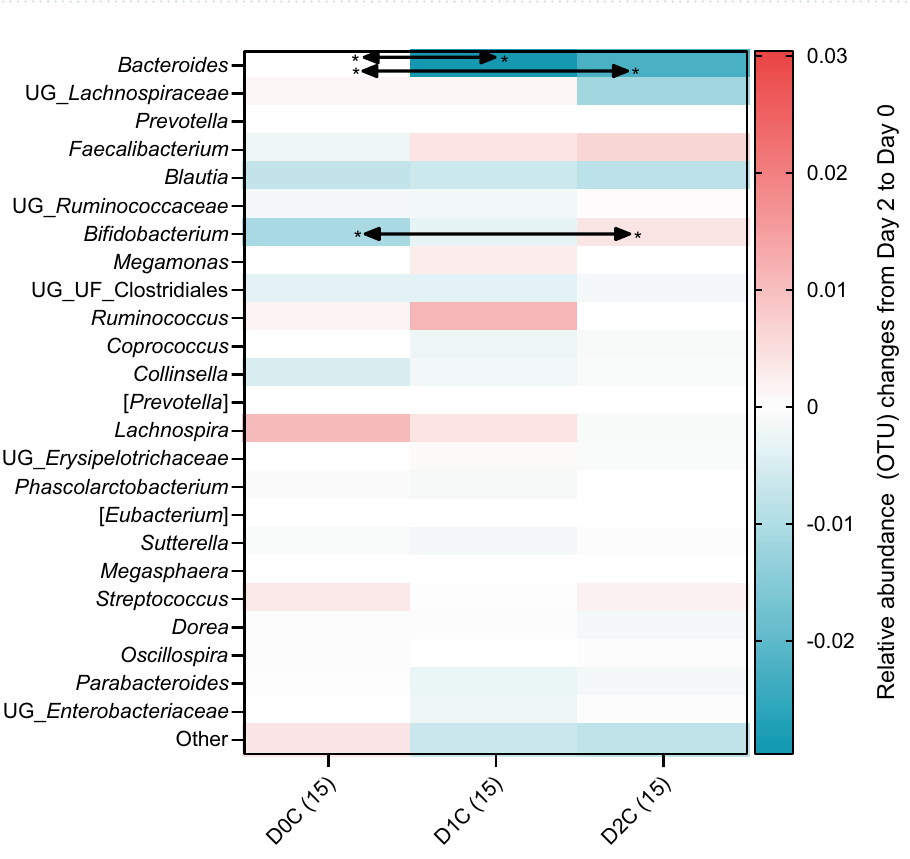
Figure 2. Alpha diversity of the three different doses of spices intervention ( a ) Chao 1’s and ( b ) Shannon’s indexes were measured and described at Y axis. No significant difference between spices intervention were found by Friedman’s test with Dunn’s multiple comparison within Day 0 or Day 2. The types and days of intervention were drawn as different symbols and colours. + shows mean. D0C = Meal with no spices intervention, D1C = Meal with low (6 g) mixed spices intervention, D2C = Meal with high (12 g) mixed spices intervention. No of samples were in the parenthesis.